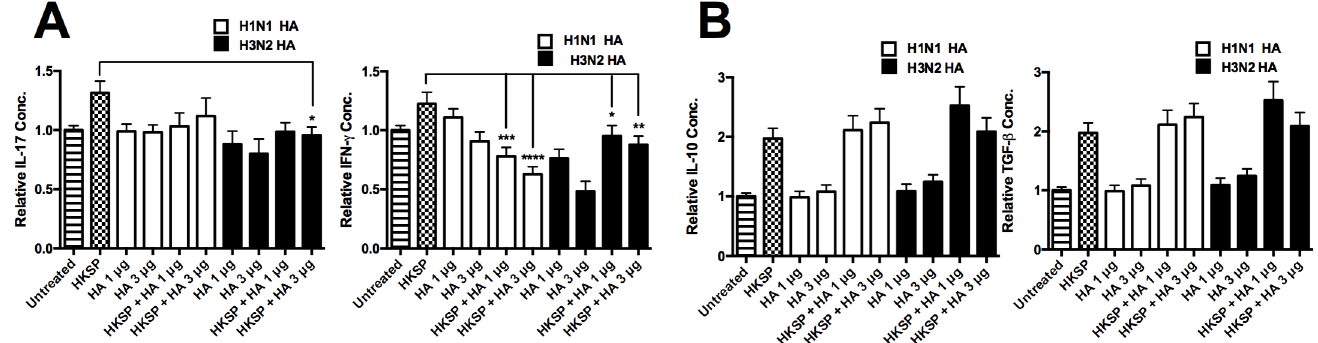
Fig 6. Influenza HA specifically attenuates adaptive cytokines in HKSP-treated cells. (A) IL-17A, IFN- γ , (B) IL-10 and TGF- β levels induced in allogeneic CD3 + T cells, co-cultured with CD14 + cells following 24 h treatment with HKSP, H1N1 HA (1μg ml -1 or 3 μg ml -1 ) or H3N2 HA (1μg ml -1 or 3 μg ml -1 ) alone or in combination with HKSP (or untreated as a control) were determined by ELISA. Each column represents normalised mean cytokine levels + SEM of at least 3 experimental repeats of each treatment/donor. Each ELISA represents normalised results from multiple donors: (A) IL-17A (n = 3), (B) IFN- γ (n = 3), (C) IL-10 and TGF- β (n = 6). Statistical analyses were performed to compare cytokine levels in cells exposed to HKSP versus cells exposed to H1N1 HA or H3N2 HA (1μg ml -1 or 3 μg ml -1 ) in combination with heat-inactivated HKSP, by fitting a One-way ANOVA to the data and using a Sidak test to adjust for multiple testing ( (cid:3) p < 0.05, (cid:3)(cid:3) p < 0.01, (cid:3)(cid:3)(cid:3) p < 0.001, (cid:3)(cid:3)(cid:3)(cid:3) p < 0.0001).